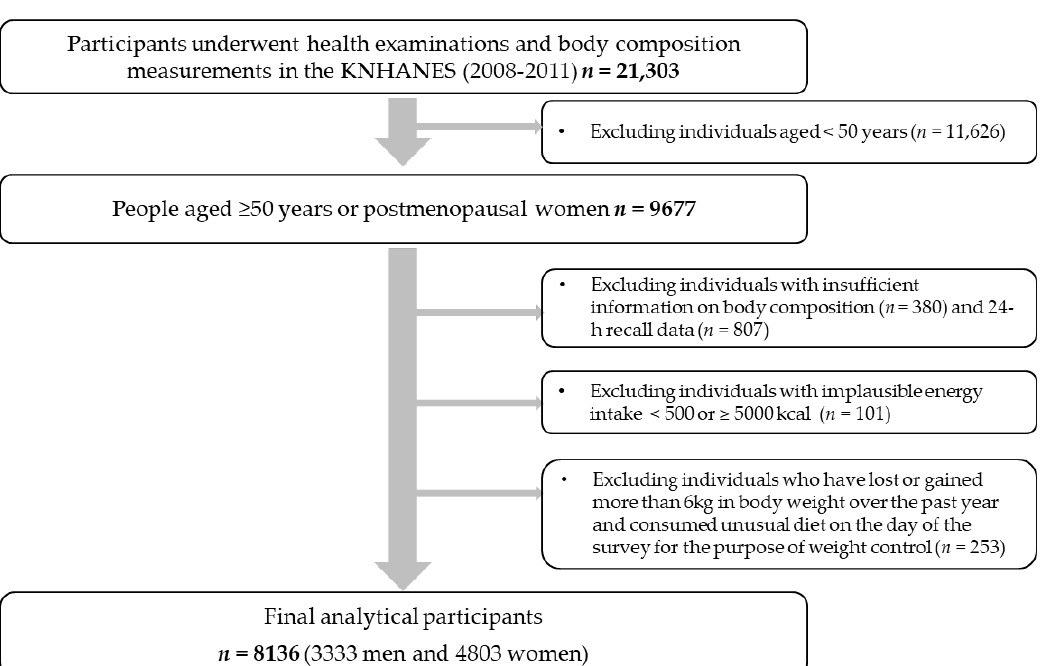
Figure 1. Flow diagram of the selection of study participants: the KNHANES (2008–2011).